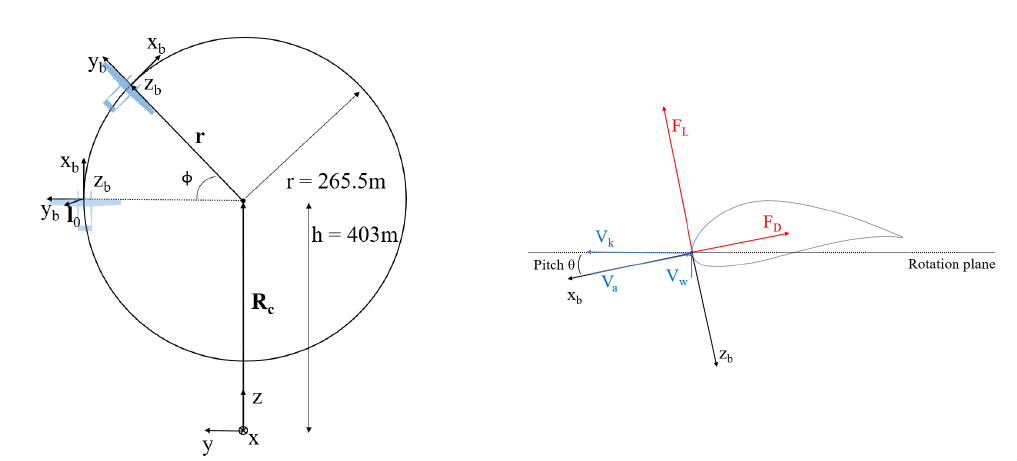
Figure 1. Multi-MW AWE reference system [16].